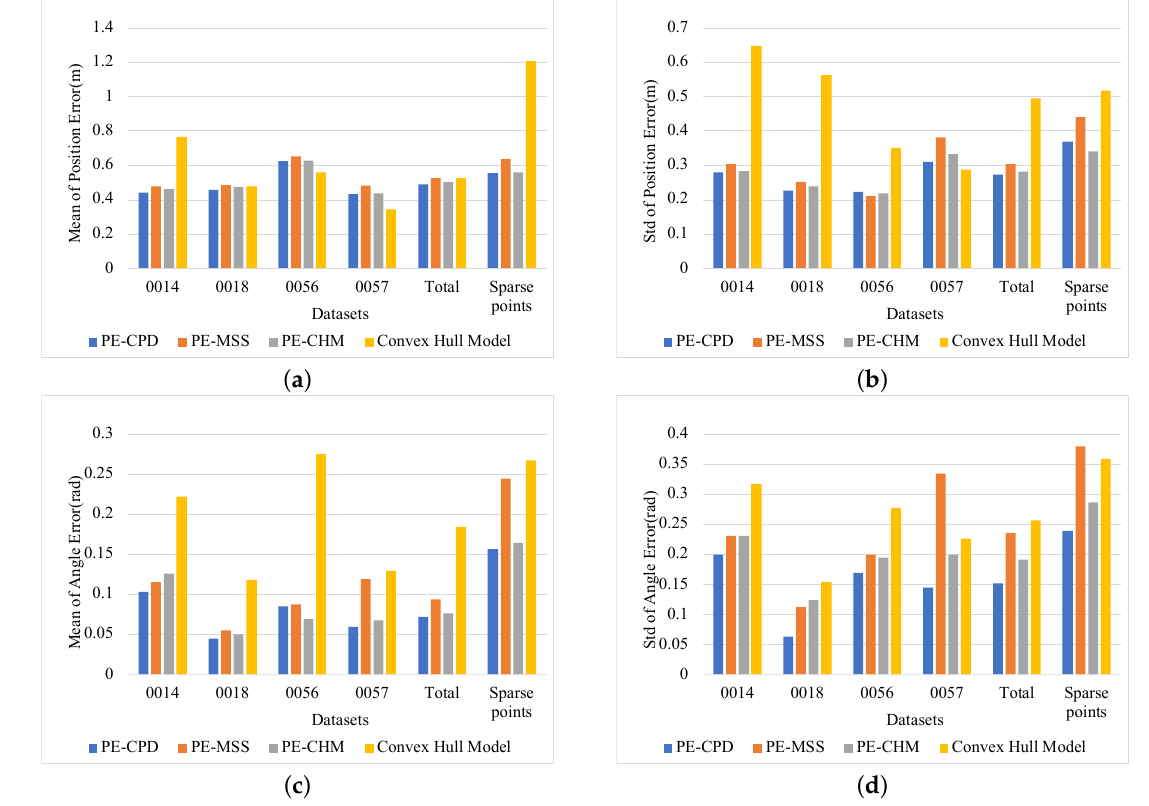
Figure 9. Statistical results of pose-estimation deviations. ( a , b ) Mean and standard deviation of position errors, respectively. ( c , d ) Mean and standard deviation of yaw angle errors,